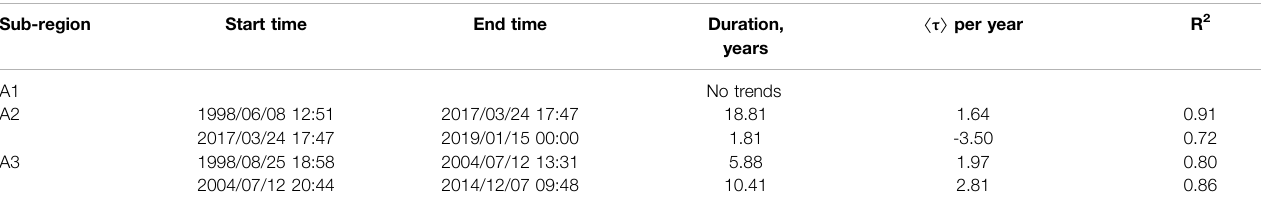
Figure 3 shows the moving averages of inter-event time 〈 τ 〉 vs. the original event time for A1 (blue line), for A2 (green line) and for A3 (red line) sub-regions. The red trend-line for seismic events in A3 displays two dropping connected with aftershocks of Table 3 lists the linear fi t intervals of 〈 τ 〉 values shown in Figure 3 , for each of the three FVG sub-regions; the inspection of linear fi t intervals, in fact, may reveal clustered irregularity of the